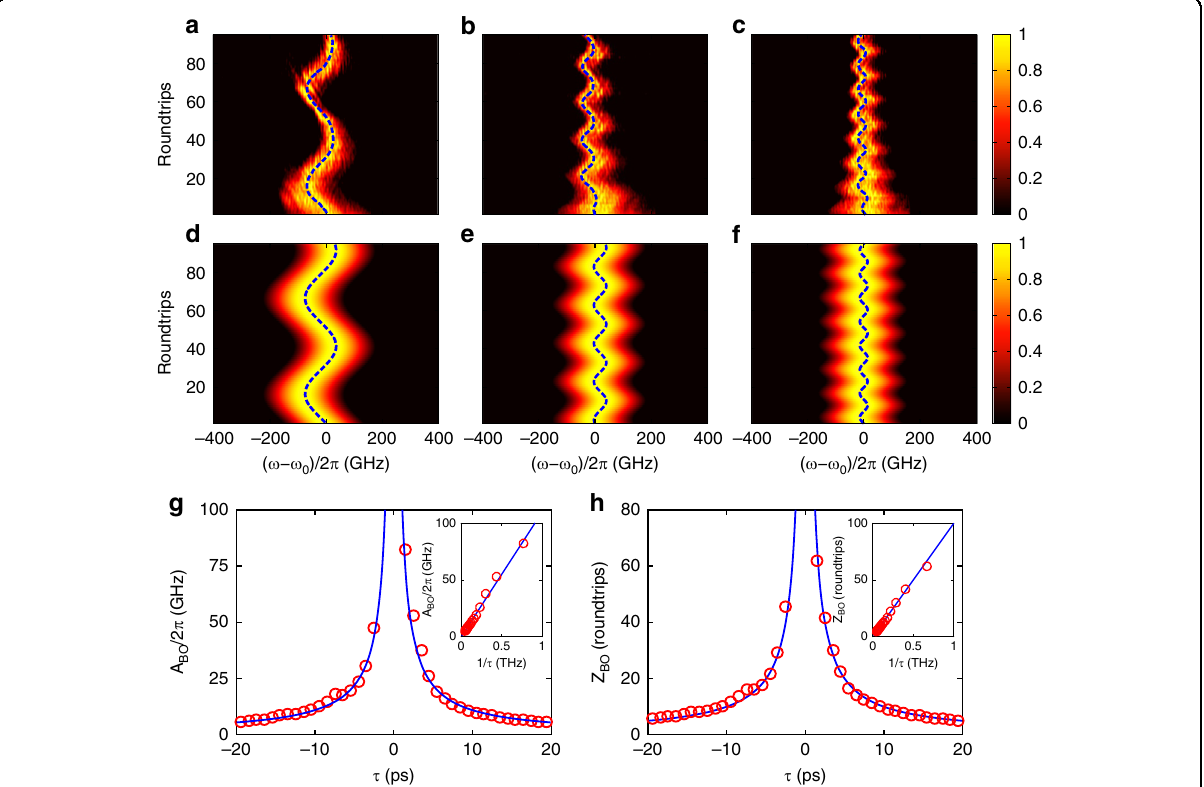
Fig. 3 BOs in the frequency dimension for T 0 = 3.5 ps. a – c Experimental results of the frequency BOs under a time detuning of τ = 2, 5 and 8 ps. Here, we set m φ = 0.7. d – f Simulated BOs corresponding to the experimental results in ( a – c ). The blue dashed lines denote the trajectories of the centre frequency. g , h Amplitude and period of the BOs as a function of the time detuning τ . The red circles and blue lines represent the experimental and theoretical results, respectively. The insets show the relations for A BO and Z BO versus 1/| τ